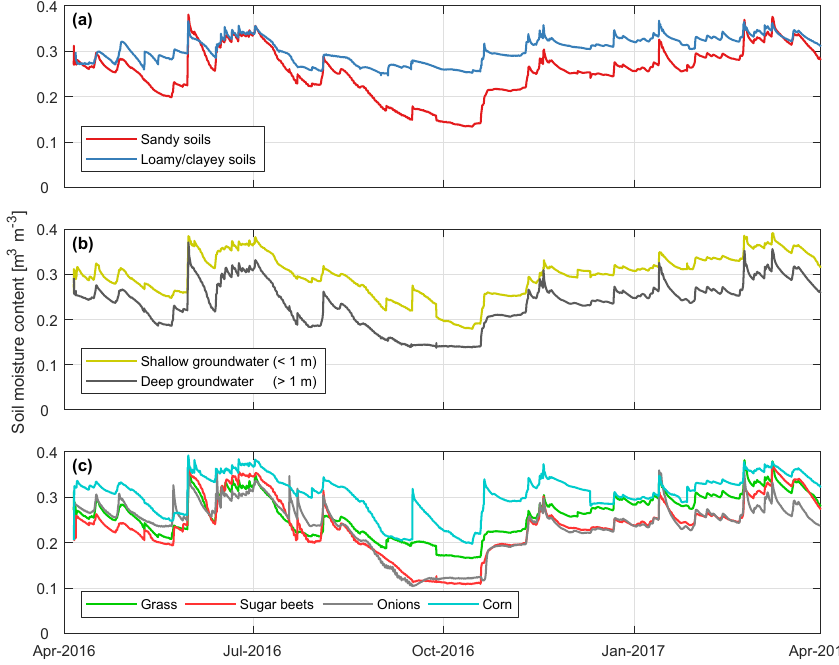
Figure 11. Influence of (a) soil type (Table 2), (b) groundwater depth (based on groundwater level measurements by Waterschap Aa en Maas) and (c) vegetation type (Table 3) on the soil moisture dynamics at 20cm depth.